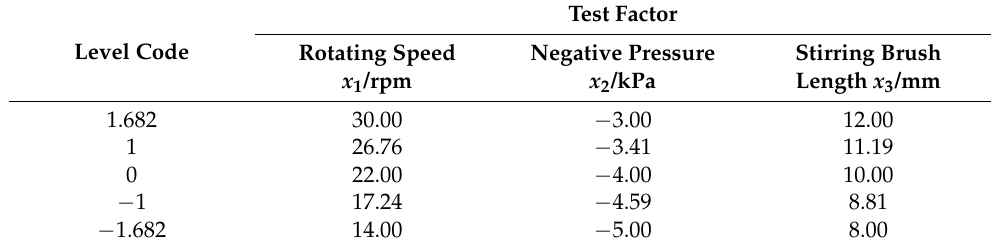
Table 3. Coding table of test factor